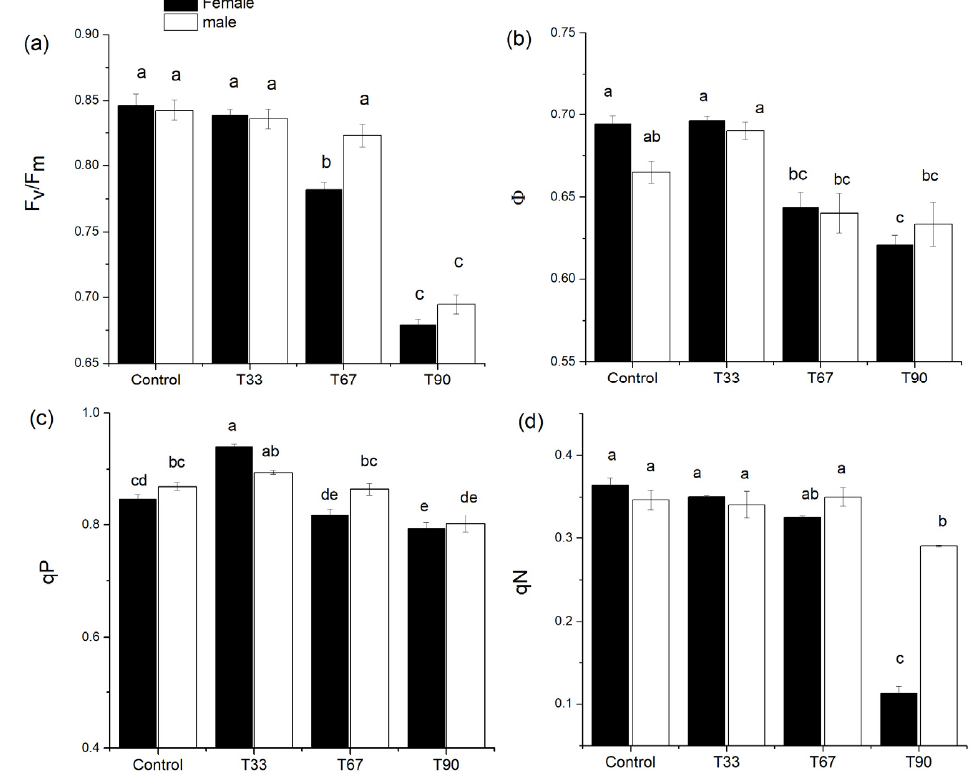
Figure 2. Mean values ( ± SE, n = 5) of chlorophyll fluorescence parameters of female and male saplings of H. rhamnoides under different sand burial treatments: ( a ) F v /F m , dark-adapted quantum yield; ( b ) Φ , effective quantum yield of PSII; ( c ) qP, photochemical quenching coefficient; ( d ) qN, non-photochemical quenching coefficient. Different lowercase letters indicate significant differences between sand burial treatments according to Bonferroni’s test ( p < 0.05).